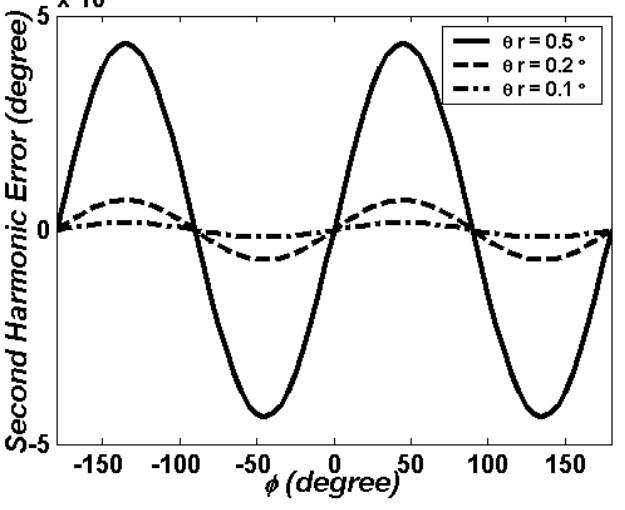
Figure 10. The second harmonic error Δ  different polarization rotation